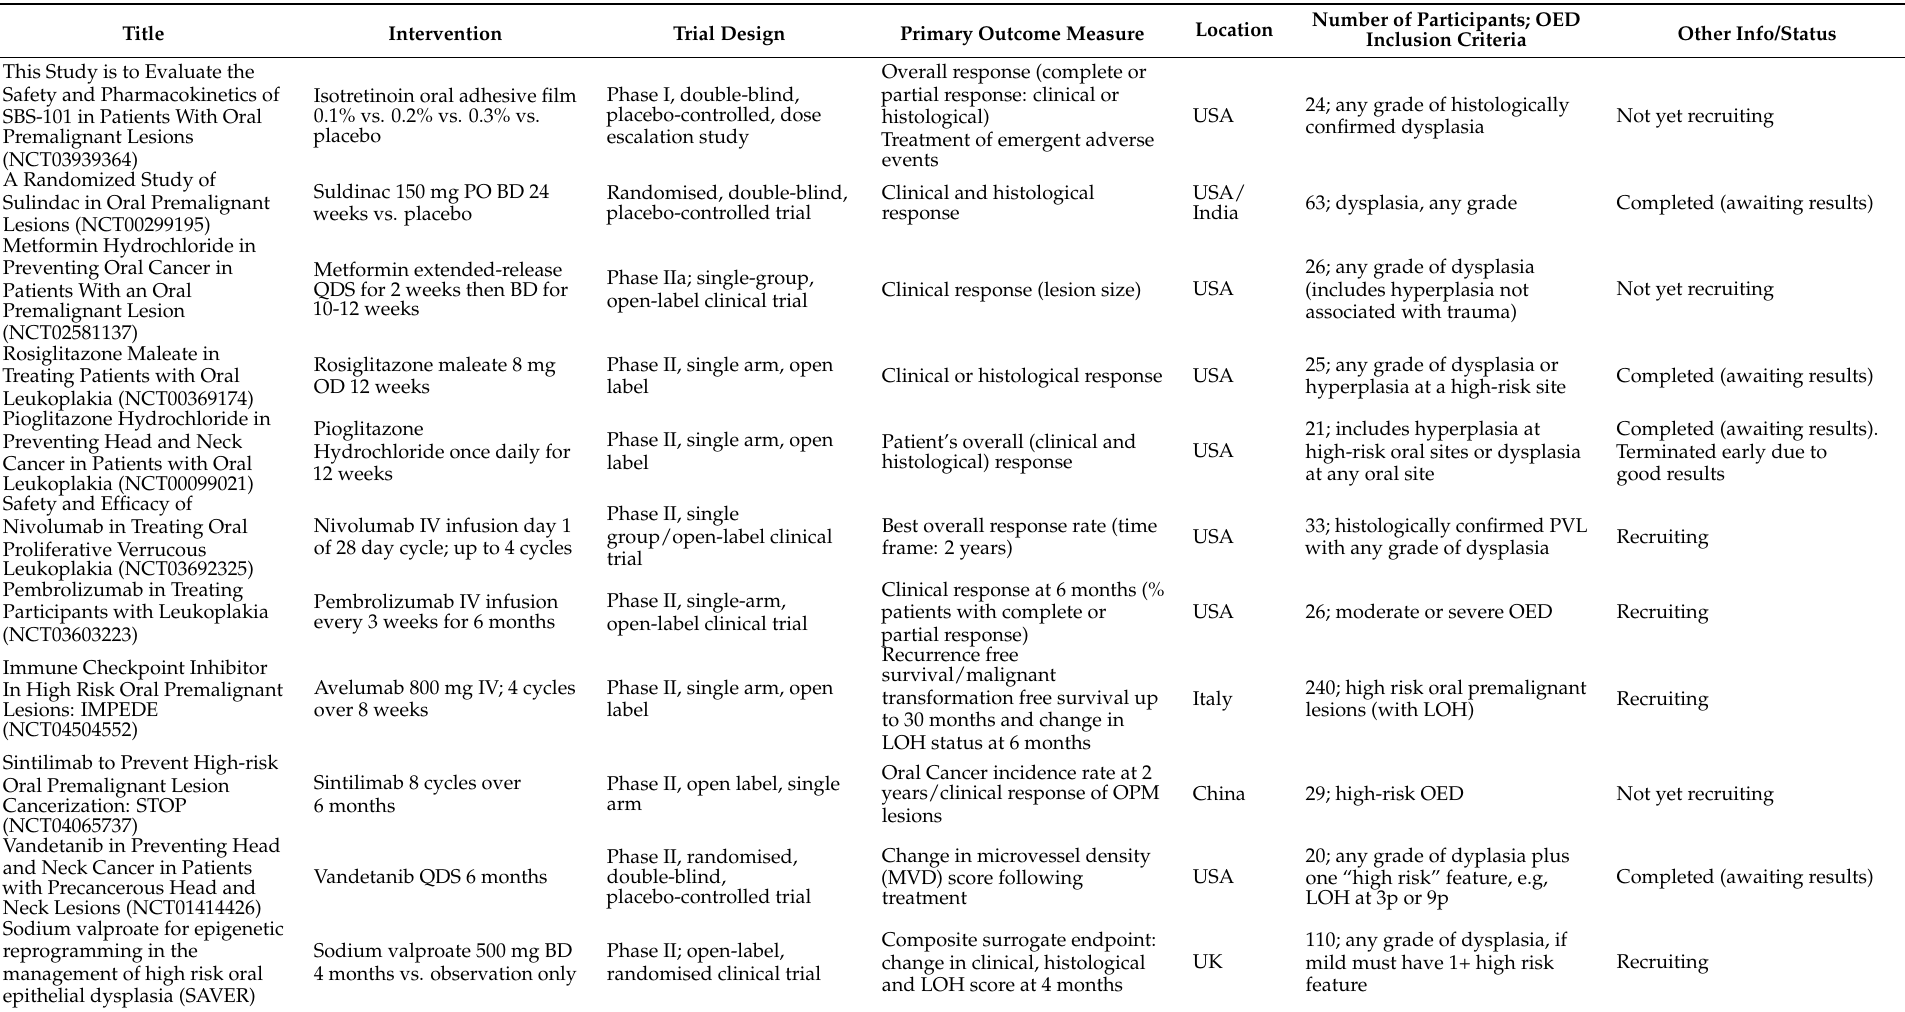
Table 2. Summary of oral cancer chemoprevention trials, recruiting or recently